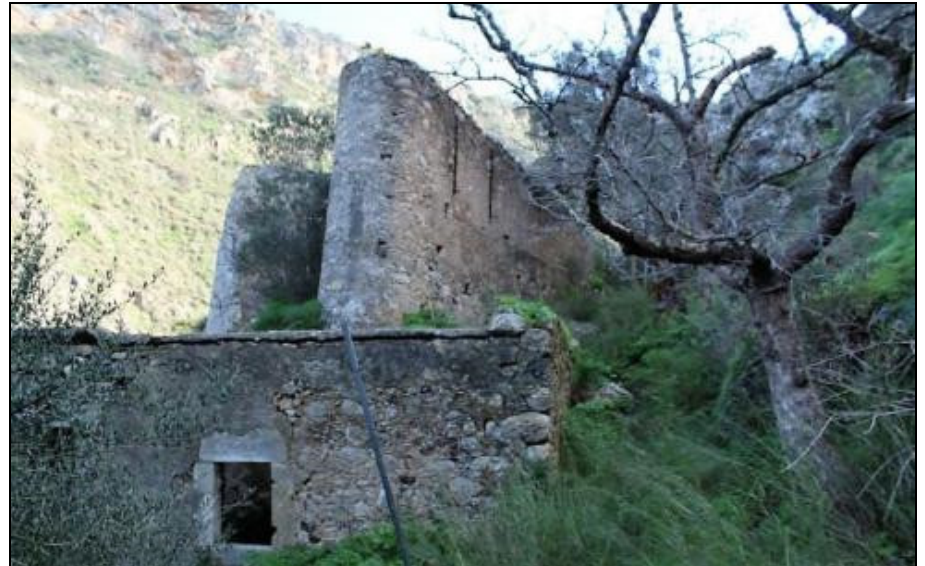
Figure 13. Water mill in Astrakous village of Iraklion County (adapted from [35]).